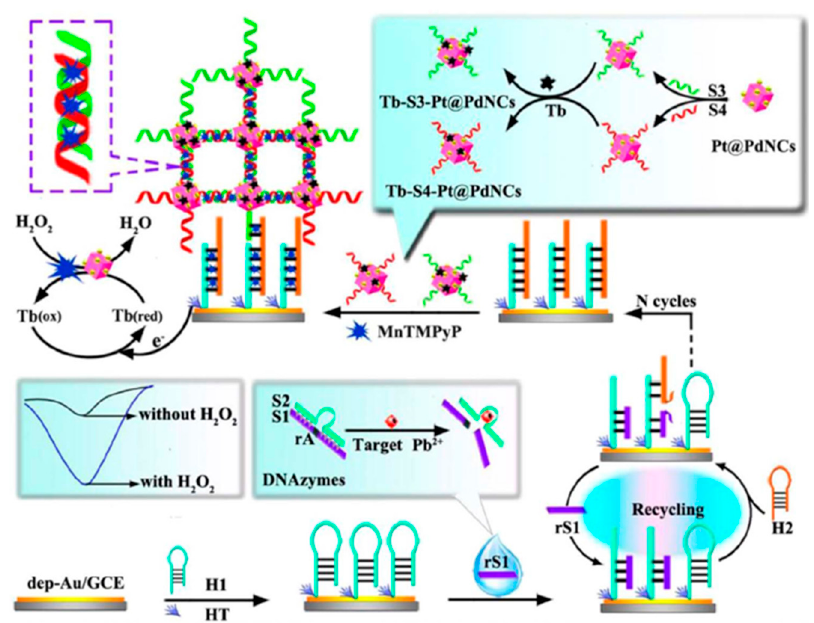
Figure 9. DNAzyme-based sensor for the voltammetric determination of Pb 2 + assisted by DSDNA and CHA and the cooperative catalysis of Pt@PdNCs and MnTMPyP for H 2 O 2 reduction. Reprinted from [52] with permission.